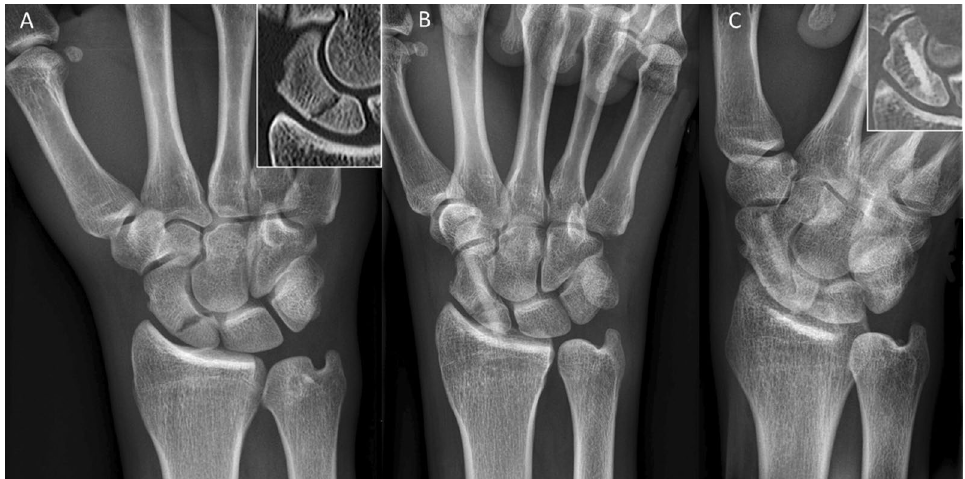
Fig. 5 Pseudarthrosis of the scaphoid in the proximal pole. A Pre-surgery, Inset : CT of the scaphoid. B 1 day post-surgery. C 10 months